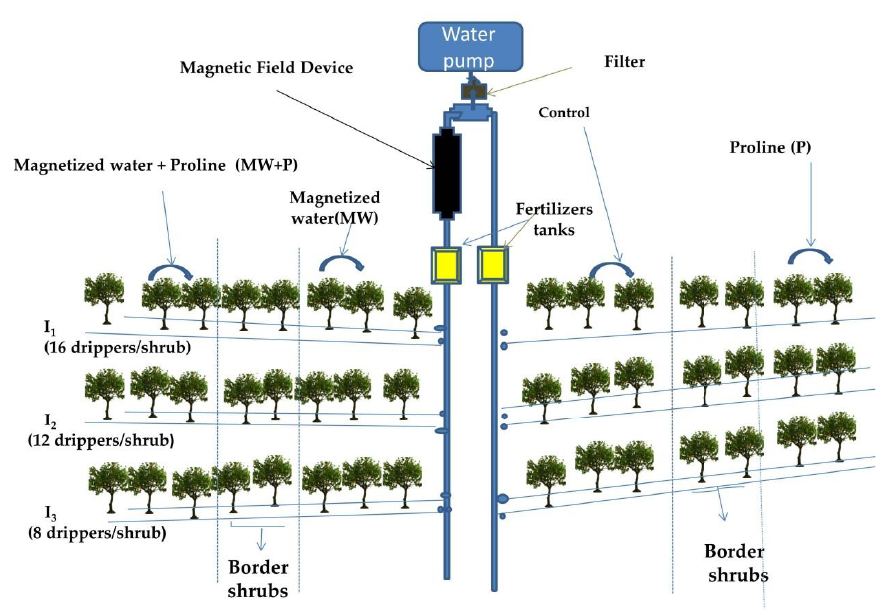
Figure 1. Layout of one block of the